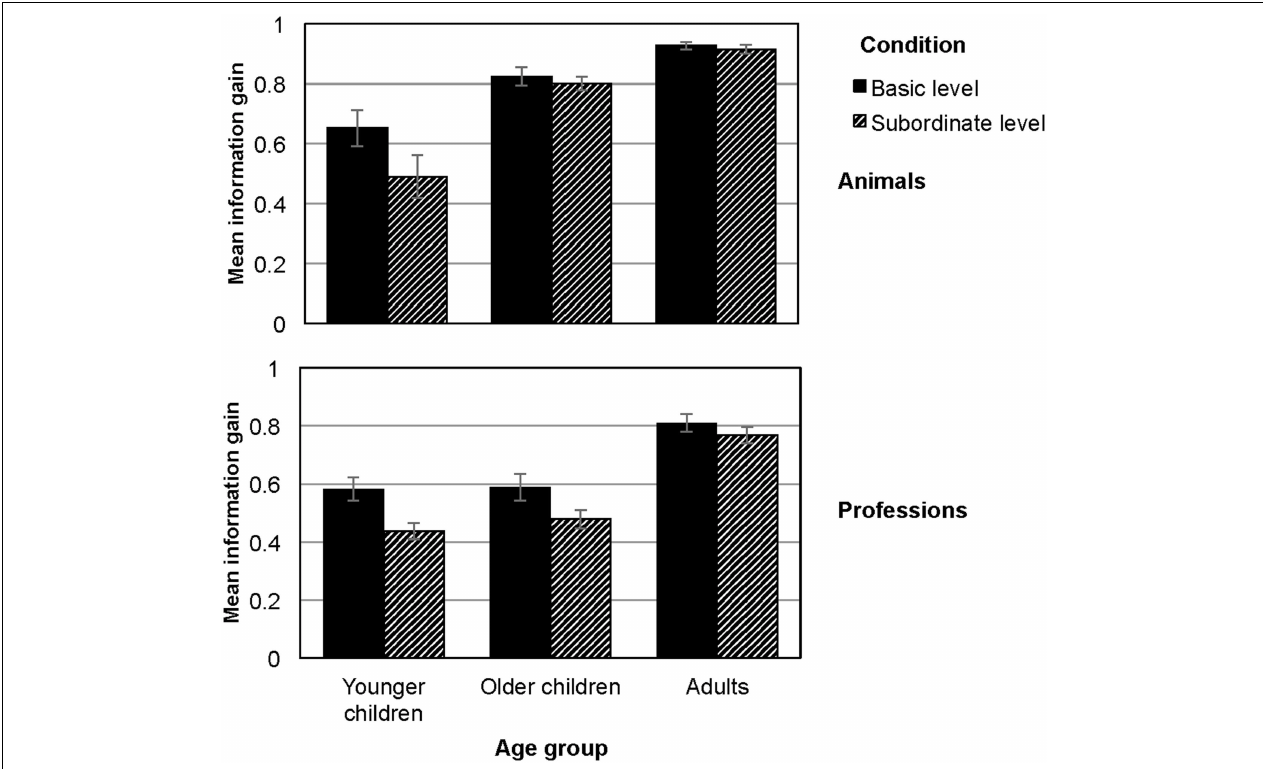
FIGURE 2 | Average effectiveness of participants’ questions in terms of information gain, displayed by domain (animals, professions) and condition (basic level, subordinate level). Error bars indicate one SEM in each direction.